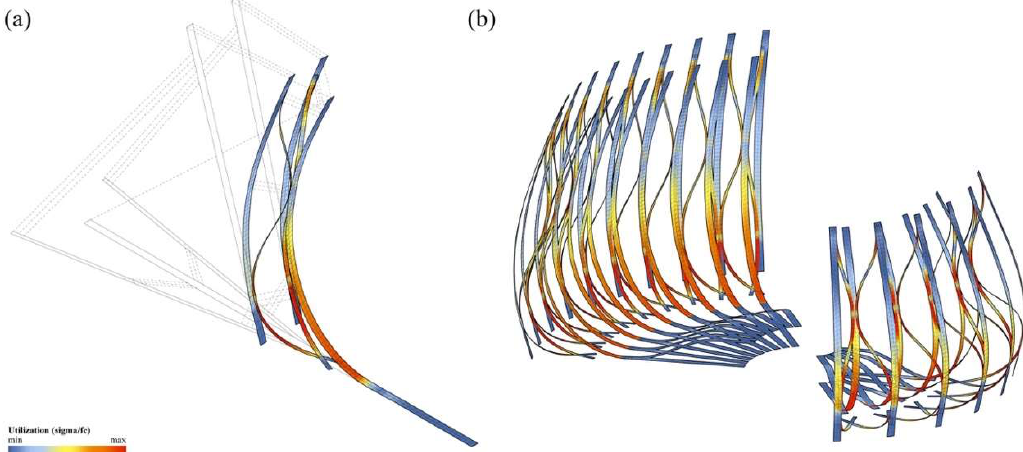
Figure 23. By using advanced FE-simulations the students determined the pavilion’s exact geometry ( a ) and analyzed the stresses in the elastically-bent carbon fiber reinforced strips ( b ).